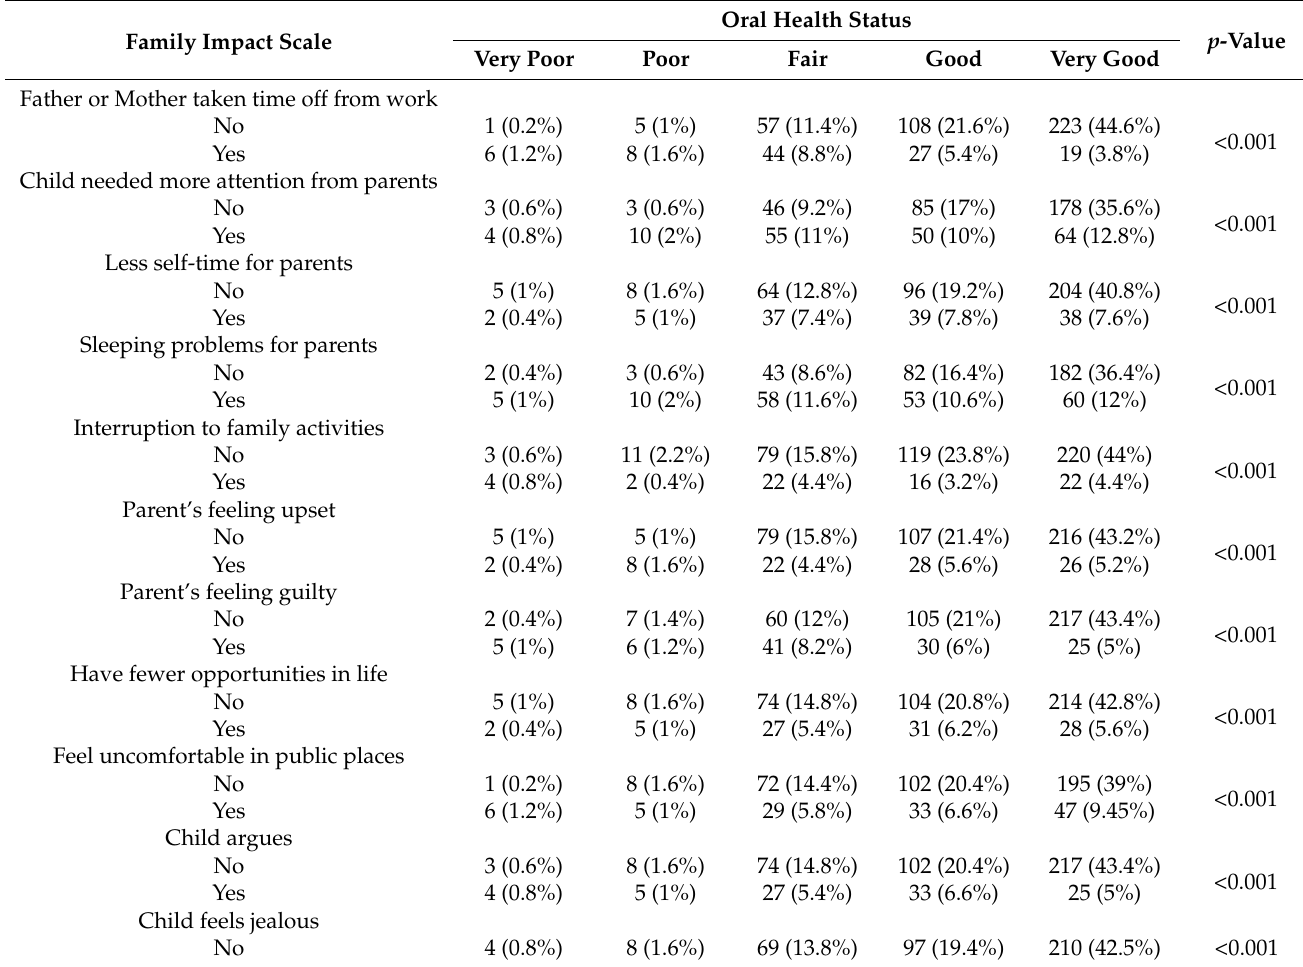
Table 4. Distribution of family impacts by the oral health status of children ( n = 500).